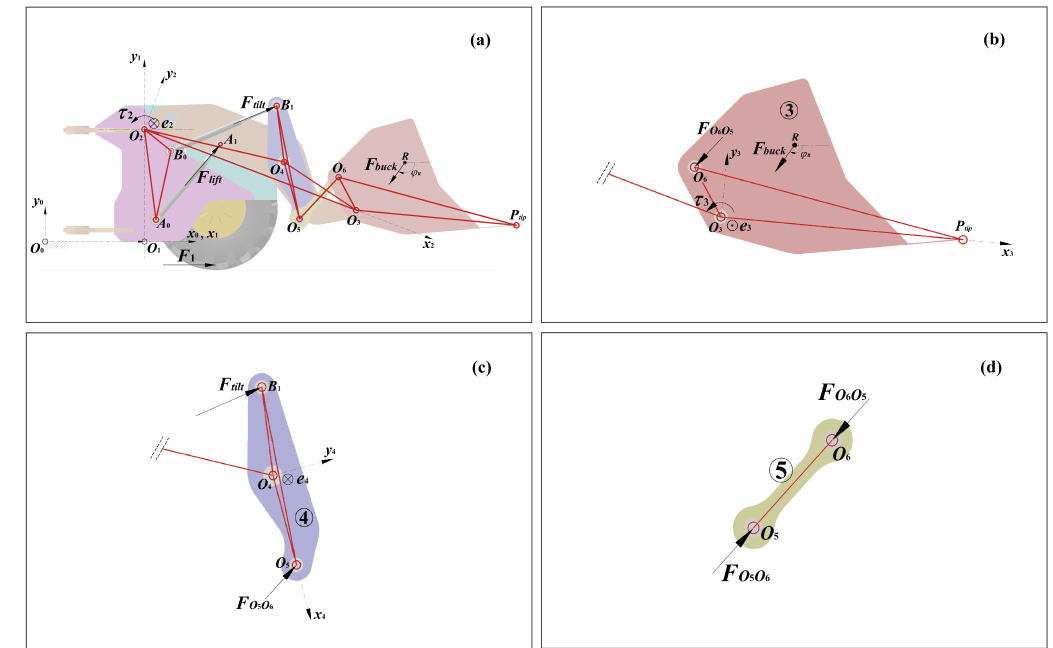
Figure 5. Multibody model of the working mechanism system. ( a ) The overall model of the mecha- nism system; ( b ) The single model of the body 3; ( c ) The single model of the body 4; ( d ) The single model of the body